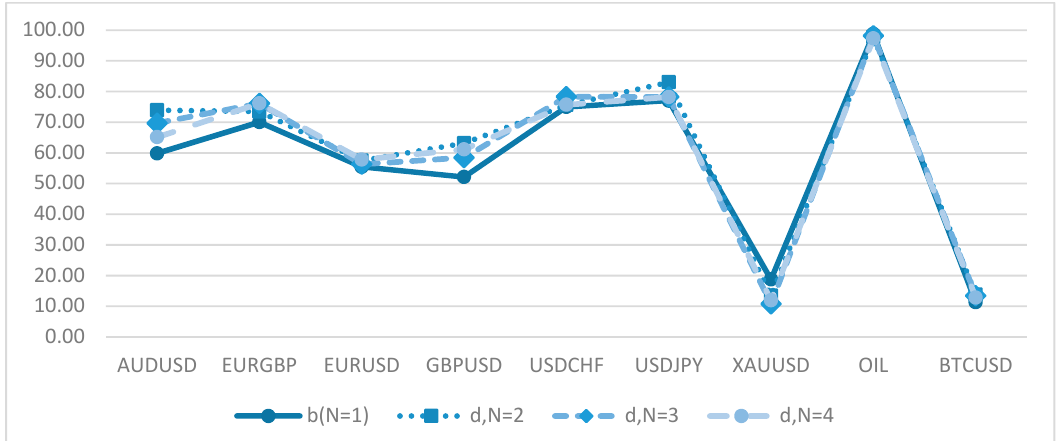
Figure 9. Drawdown, as percentage of equity, of experiment (d) for various values of N.